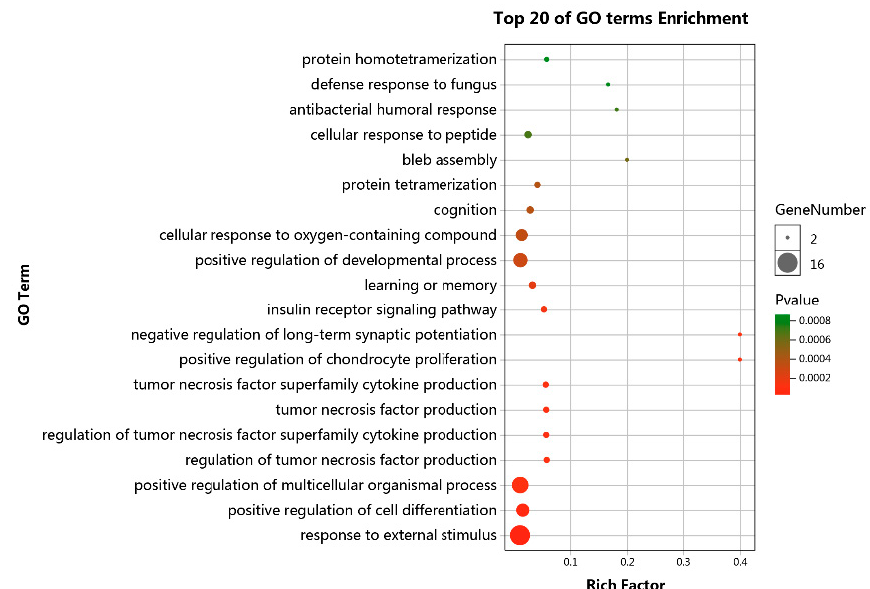
Figure 4. GO analyses of mRNAs involved in the lncRNA-related competing endogenous RNA (ceRNA) network.